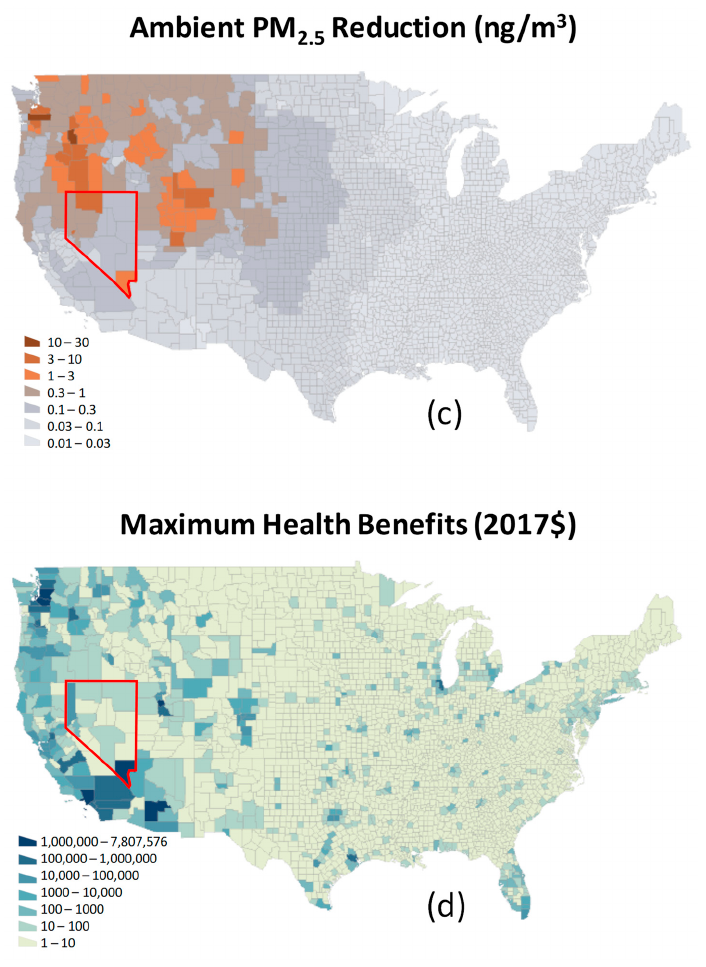
Figure 1. Distribution of ( a ) AVERT regions [16] and ( b ) CO 2 emission reductions, ( c ) ambient PM 2.5 reductions, and ( d ) maximum health benefits at the county level, attributed to the Nevada 50% RPS policy by 2030. The State of Nevada is highlighted.